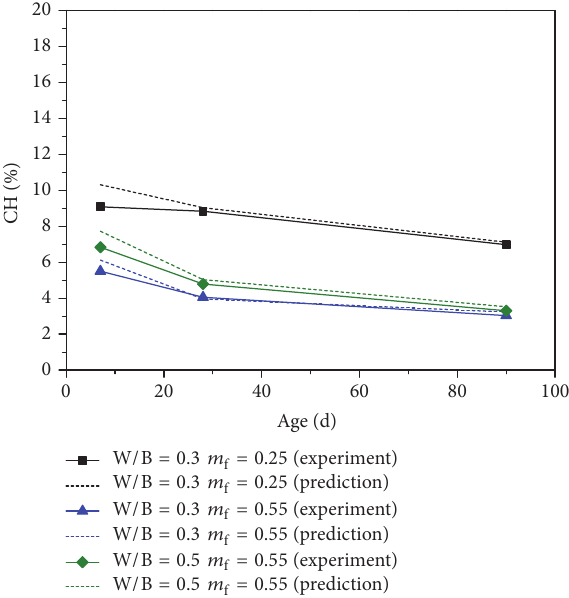
Figure 12: The predicted and measured values of CH content of cement-fly ash pastes.